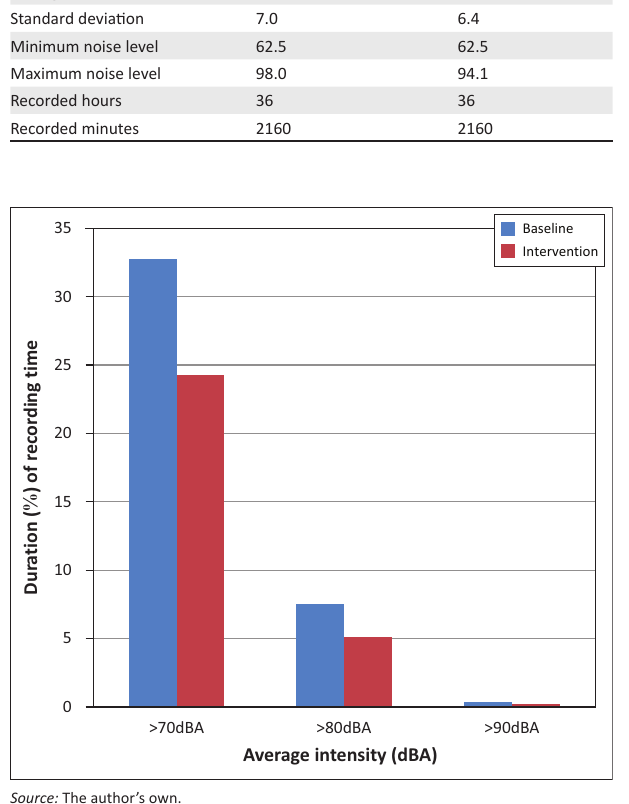
FIGURE 2: Distribution ( % ) of recorded noise levels for the duration of baseline and intervention